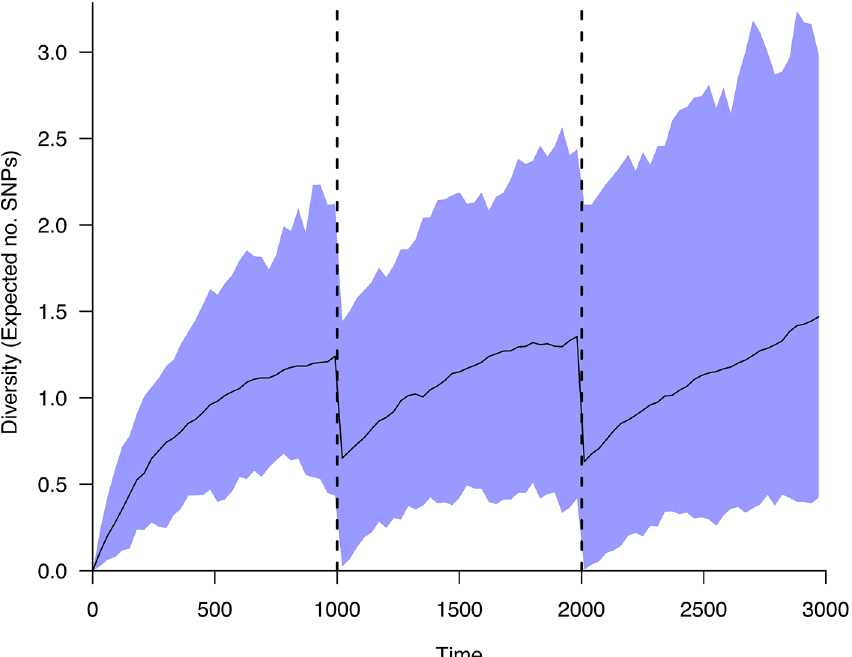
Fig 3. Genomic diversity in a population undergoing bottlenecks. Expected diversity within a population undergoing bottlenecks of size 2 at times 1000 and 2000. A total of 100 populations were simulated over 3000 generations, starting with a single genotype. The black line indicates the mean diversity of the simulations, with the shaded blue area representing the central 95% quantile. Figure plotted using the diversity.range()